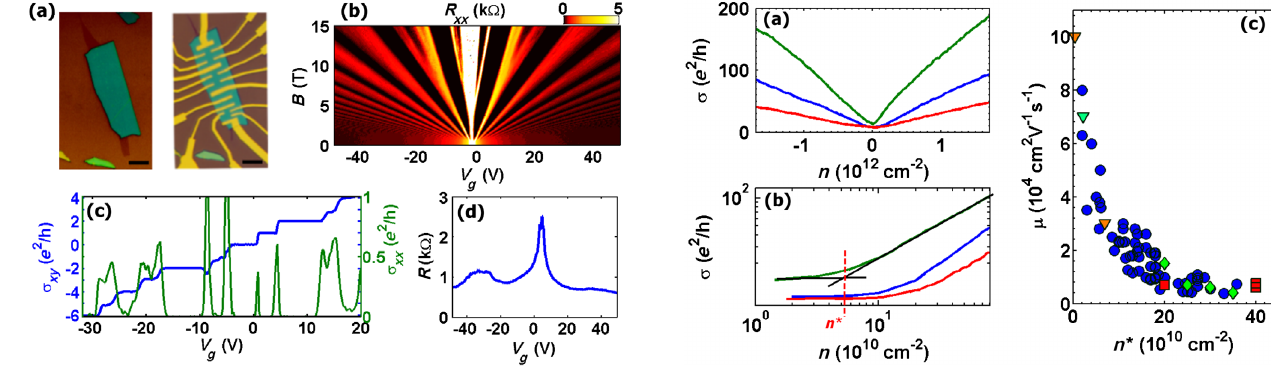
FIG. 2. Conductivity σ of a graphene monolayer on hBN as a 1. (a) Optical microscope image of a monolayer graphene function of carrier density n in linear (a) and double-logarithmic flake on top of a 30-nm-thick hBN crystal before (left) and after (b) scale, measured after fabrication (blue line), after a first (right) depositing metal contacts (the scale bars are 5 μ m). annealing at 150 °C (green line), and after a second annealing at (b) Longitudinal resistance R as a function of V and B xx g 250 °C (red line). Panel (b) also illustrates the procedure to extract showing quantum Hall states originating from the lifting of the value of n (cid:1) . (c) The blue full circles represent the low- the single-particle degeneracy already at B ≃ 8 T. (c) Hall (blue temperature mobility μ (plotted versus n (cid:1) ) for all the 15 graphene- line) and longitudinal (green line) conductivity as a function of on-hBN devices realized in our laboratory, measured after V measured at B ¼ 15 T, showing full degeneracy lifting of g fabrication or after annealing. The triangles represent data for Landau level N ¼ 0 , 1. (d) Resistance of a graphene device graphene on hBN extracted from Refs. [1,5] (orange triangles) whose edge was aligned to that of the hBN substrate, showing the and from Ref. [2] (green triangle). The green diamonds and red emergence of satellite Dirac peaks (well developed for negative squares are from devices realized in our laboratory on SiO 2 and V and less pronounced for positive V ). All measurements have g g SrTiO 3 substrates, been taken at T ¼ 250